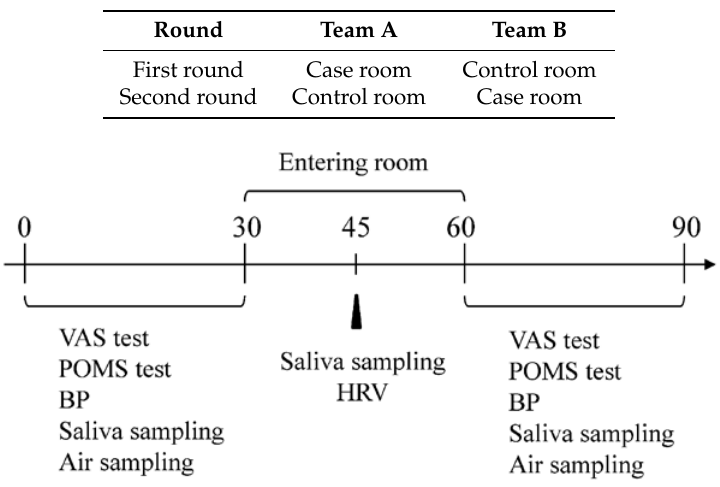
Table 2. Experimental design.